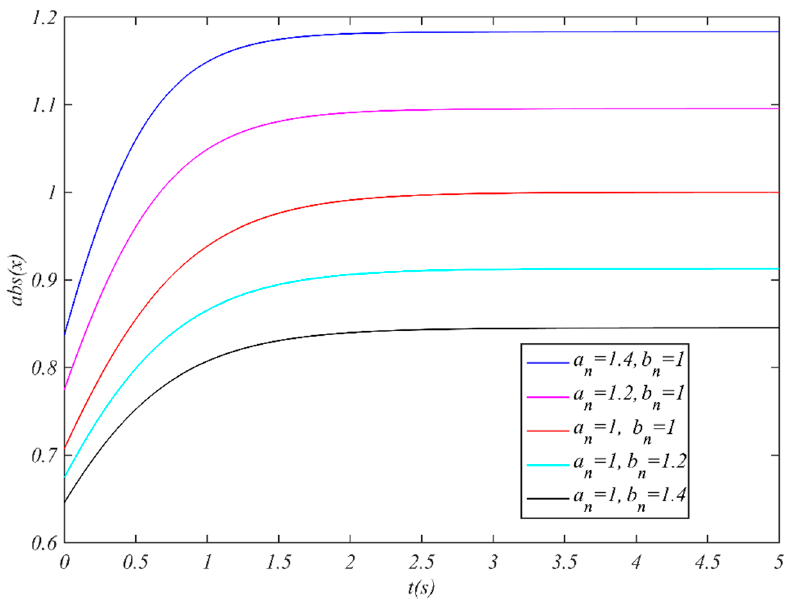
Figure 1. Effect of parameters of CBSR model on saturation phenomenon.